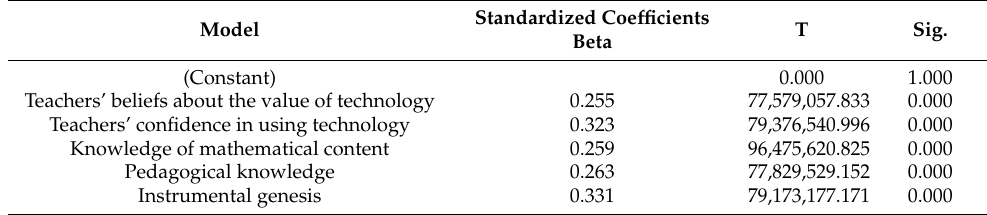
Table 1. Values of Beta appropriate for predicting teachers’ PTK from its components. Standardized Coefficients Model